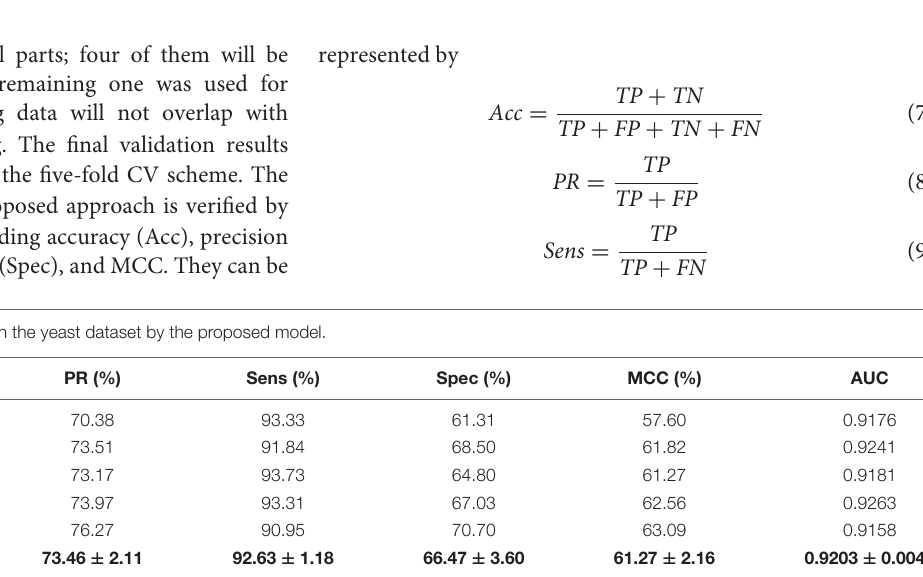
FIGURE 7 | Five-fold CV results obtained by DNN classifier with different feature descriptors on the Oryza sativa dataset. (A) is the ROC curves obtained by DCT descriptors; (B) is the ROC curves obtained by FFT descriptors; (C) is the ROC curves obtained by DWT; (D) is the ROC curves obtained by AC.